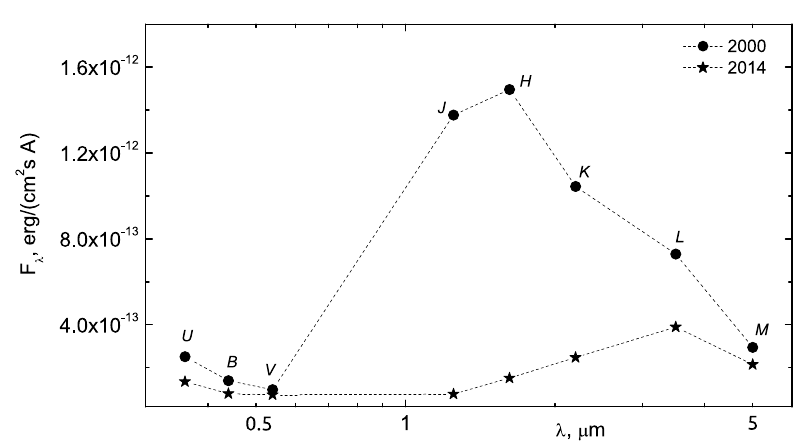
Fig. 4. The observed spectral energy distribution of V1016 Cyg from UBVJHKLM photometry in 2000 and 2014.